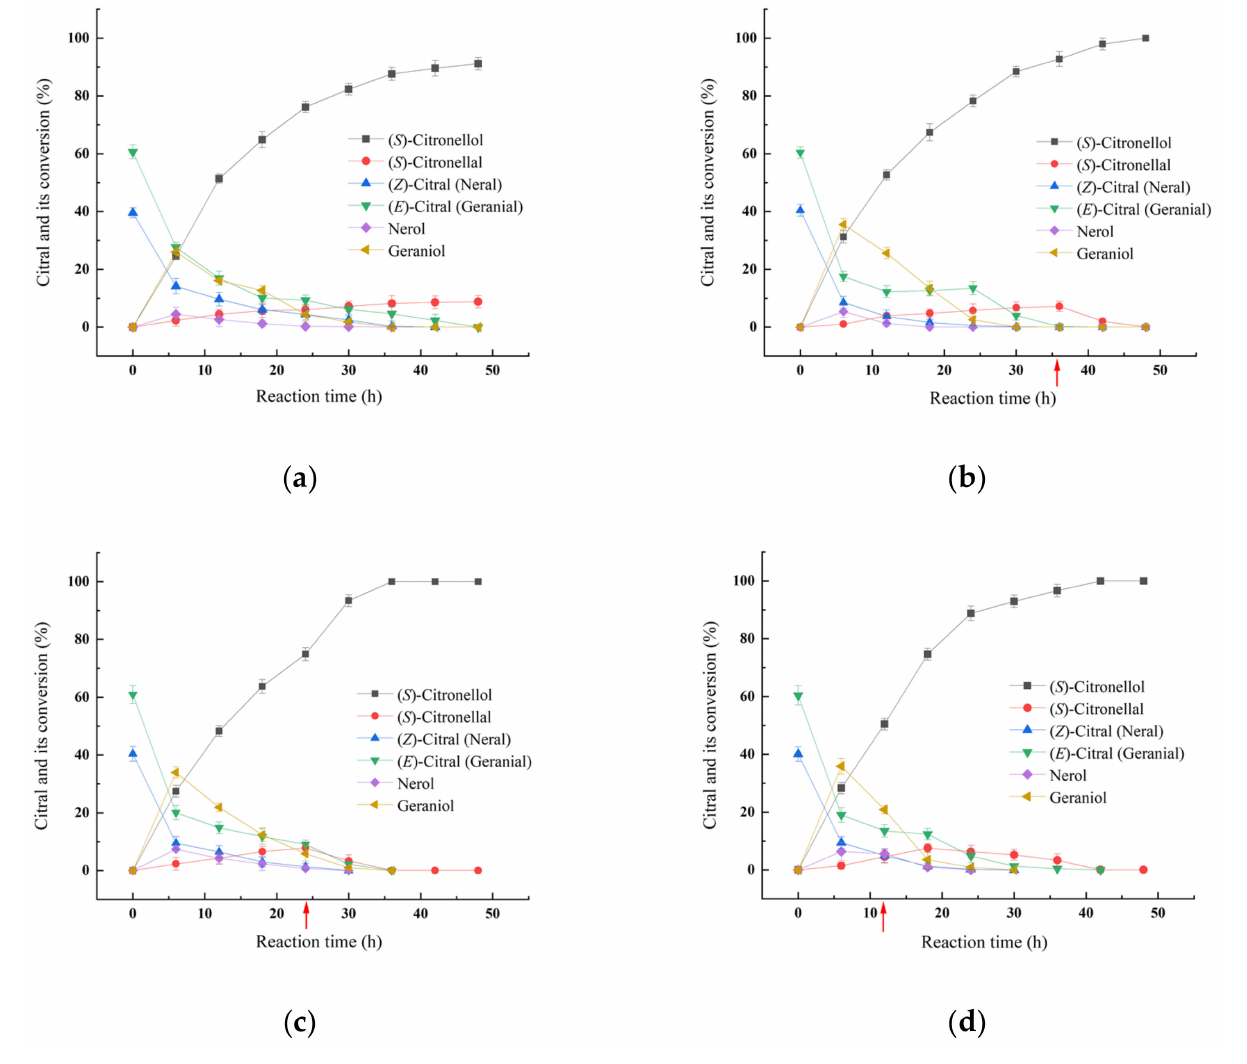
Figure 6. Time-courses of enzymatic double reduction of 400 mM ( E / Z )-citral to ( S )-citronellol with/without the feeding of the cells expressing BmGDH M6 . The reaction mixture (10 mL) contained 400 mM ( E / Z )-citral, 1200 mM glucose, 1 g wet cells, 0.4 mM NADP + , 20% ( v/v ) isopropanol, and 50 mM PIPES buffer (pH 6.5). The reactions were conducted at 30 ◦ C and 400 rpm for 48 h. ( a ), no feeding of the cells expressing BmGDH M6 . ( b ), the feeding of 0.5 g wet cells expressing BmGDH M6 at 36 h. ( c ), the feeding of 0.5 g wet cells expressing BmGDH M6 at 24 h . ( d ), the feeding of 0.5 g wet cells expressing BmGDH M6 at 12 h. The red arrows represent different timing for feeding the cells expressing BmGDH M6 . Standard deviations are indicated in the diagram ( n =